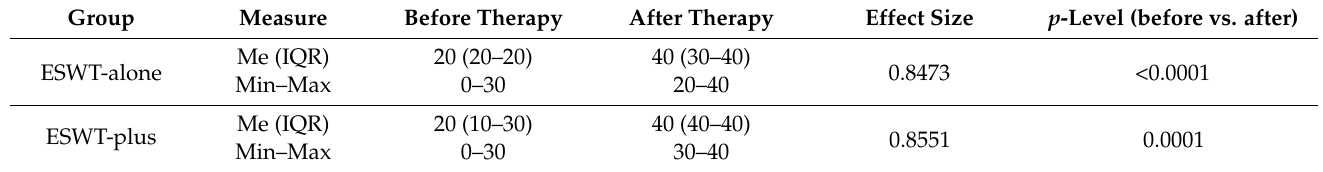
Table 8 presents the function point scores (AOFAS—Function) before and after therapy.